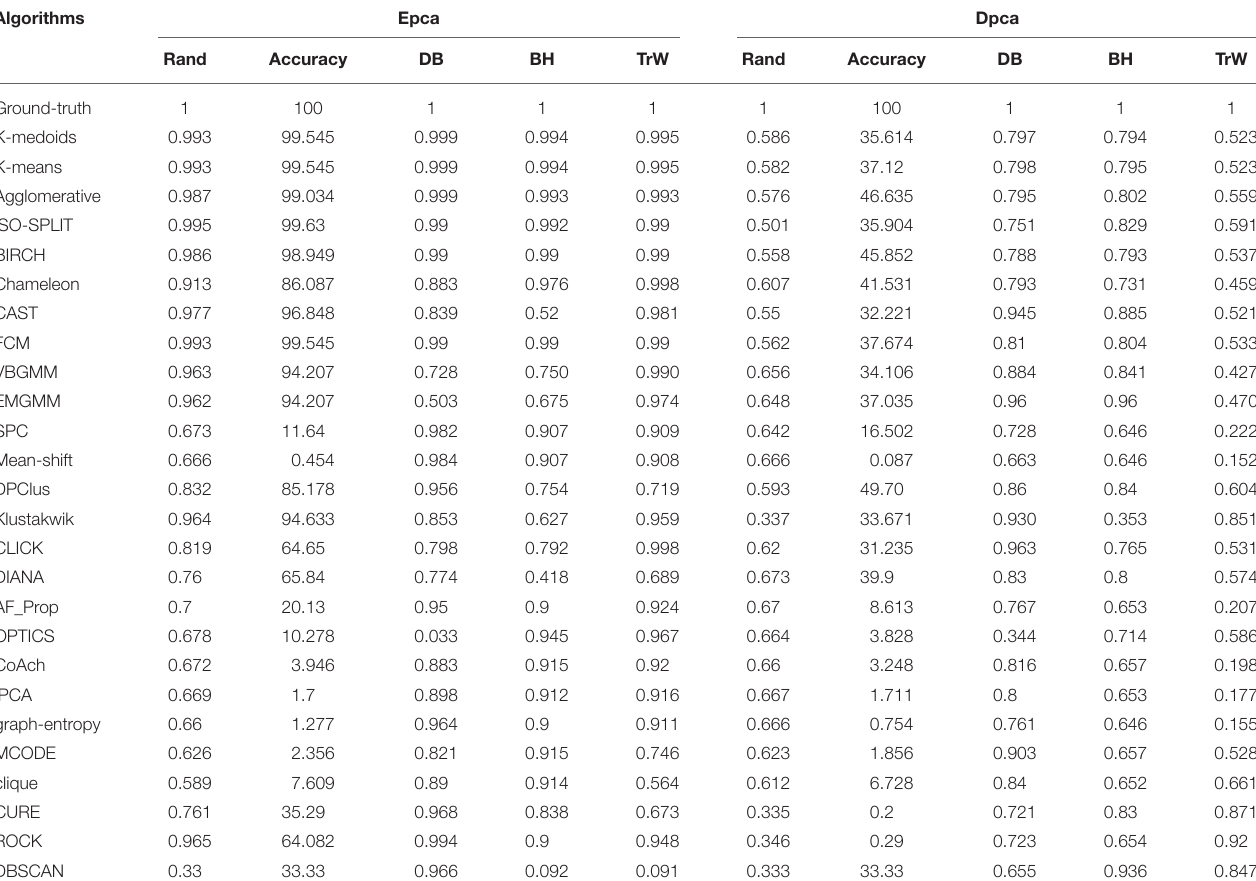
TABLE 2 | A summarized version of clustering algorithms performance